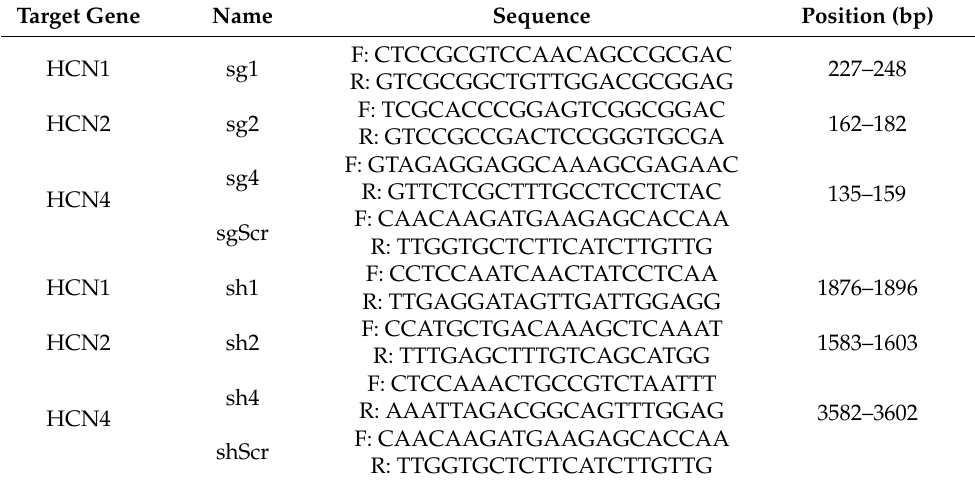
Table 4. Sequences and Positions of Functional sgRNAs and shRNAs. Sequences of Individual sgRNAs and Their Target Positions Relative to the Transcriptional Start Site (TSS) and Sequences of Individual shRNAs and Their Target Positions Relative to the ATG Start Codon are Summarized. Target Sequences of sgRNAs are Based on the Predicted TSS from the Eukaryotic Promoter Database (EPD) [28]. Target Sequences for shRNAs are Based on the Murine mRNA Sequences NM_010408.3 for HCN1, NM_008226.2 for HCN2, and NM_001081192.1 for